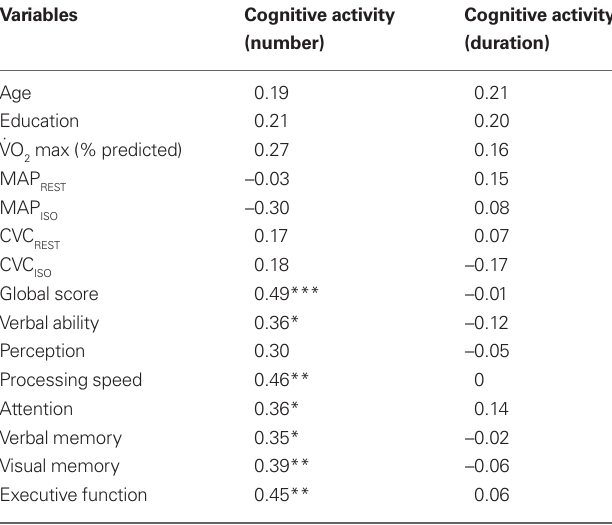
Table 3 | Correlation of cognitive activity with demographic variables, fitness, vascular health and relative cognitive domain scores.